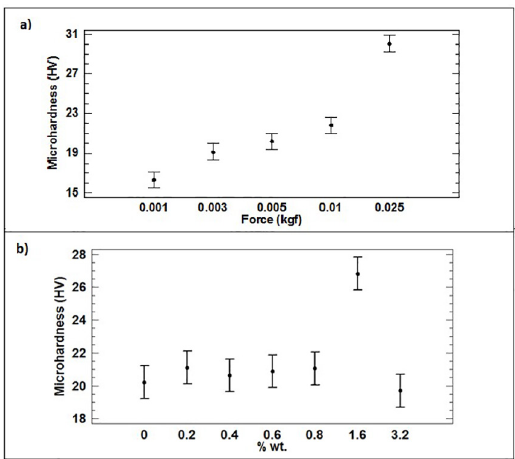
Figure 8. ANOVA results, hardness as response variable, factors: a) force, b) CNTs wt%.